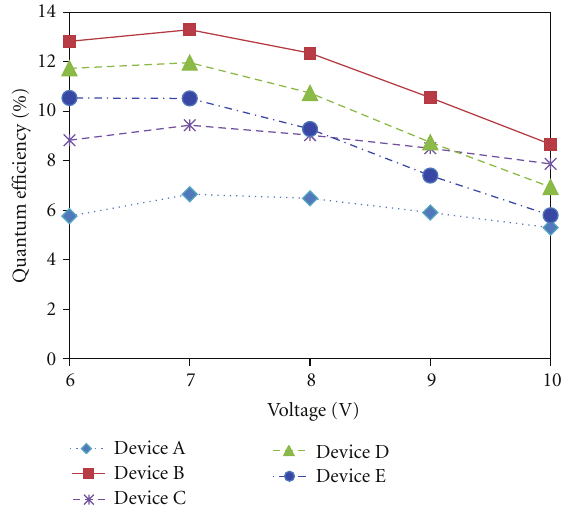
Figure 6: Quantum e ffi ciency-voltage characteristics of the fabri- cated devices.